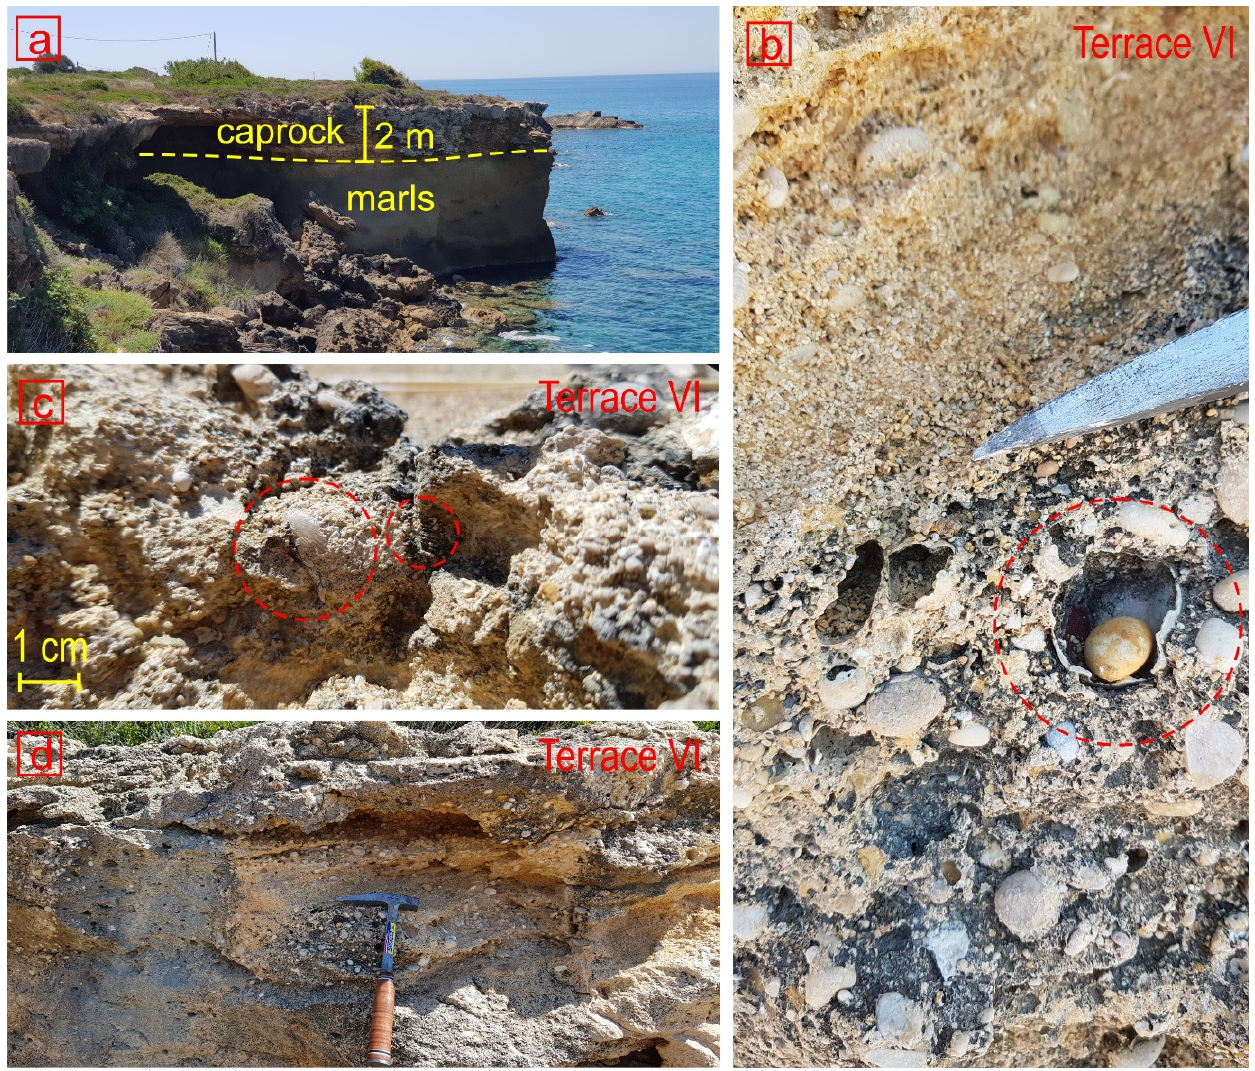
Figure 6. ( a ) Drone image of terrace VI exposure at 38°06 ′ 21.7 ″ N 20°30 ′ 41.6 ″ E (view southeast). Yellow dotted line represents the unconformable contact between the caprock and the underlying marls of Pliocene age. ( b , c ) Close-up of caprock formation consisting of a well-cemented coarse sand and subrounded pebbles of limestone composition. Dotted circles represent isolated bivalves and bivalve fragments ( d ) Close-up of a less complete and extensive sequence of the well-cemented caprock (same stratigraphy) on adjacent private land at 38°09 ′ 41.6 ″ N 20°28 ′ 49.0 ″ E.